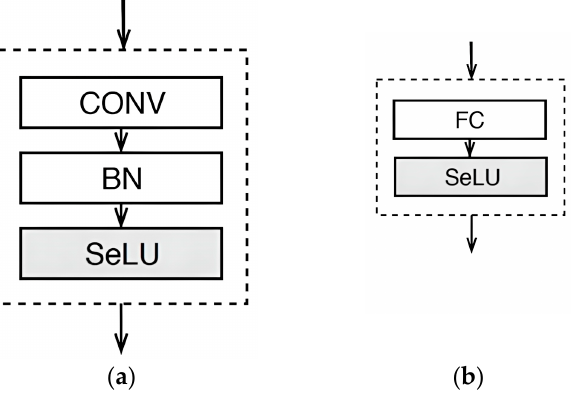
Figure 4. Building Blocks of the CNN Model. ( a ) CONV Block, ( b ) FC Block.